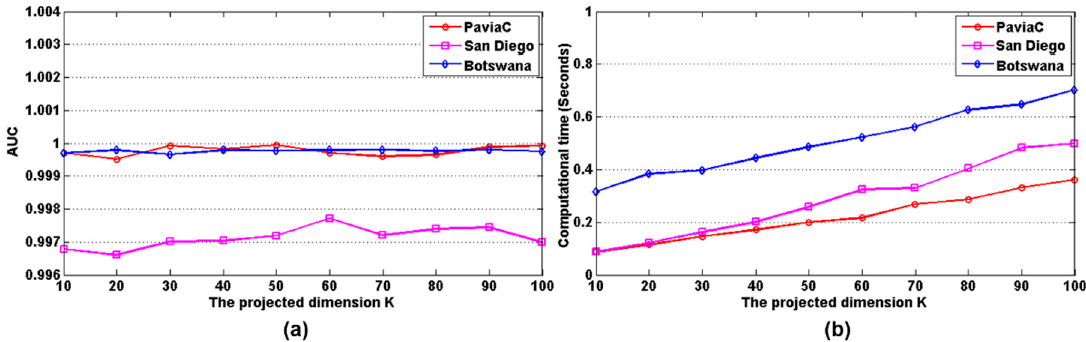
Figure 15. The curves of: ( a ) area under curve (AUC); and ( b ) computation time with different choices of projected dimension K on the three HSI datasets. of projected dimension K on the three HSI